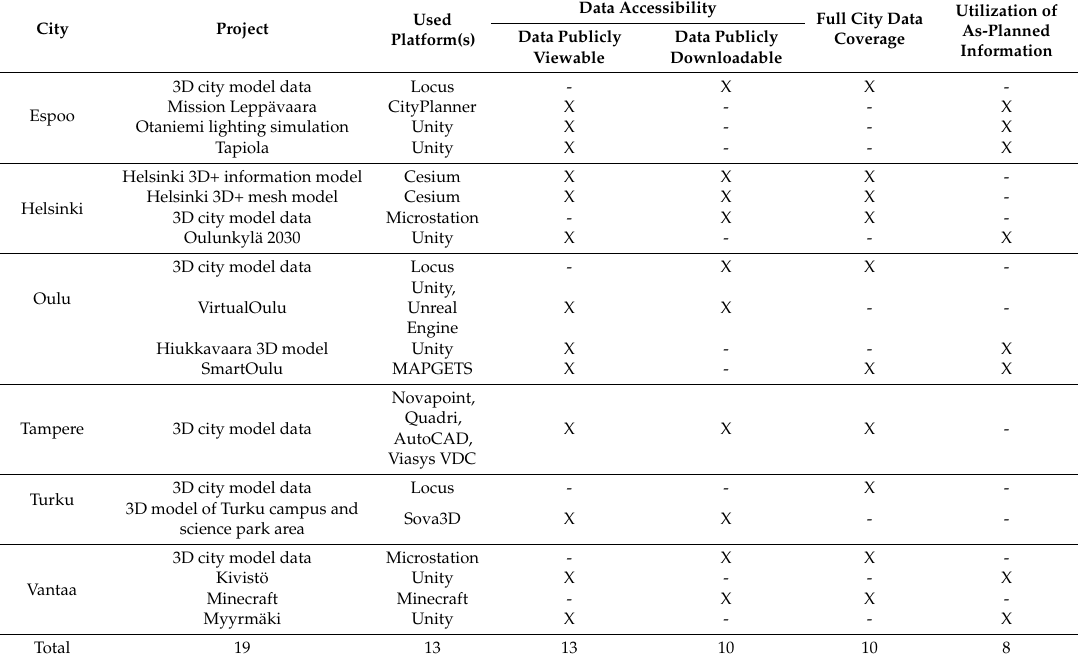
Table 3. A summary of the analyzed 3D city modeling activities based on the selected indicators.